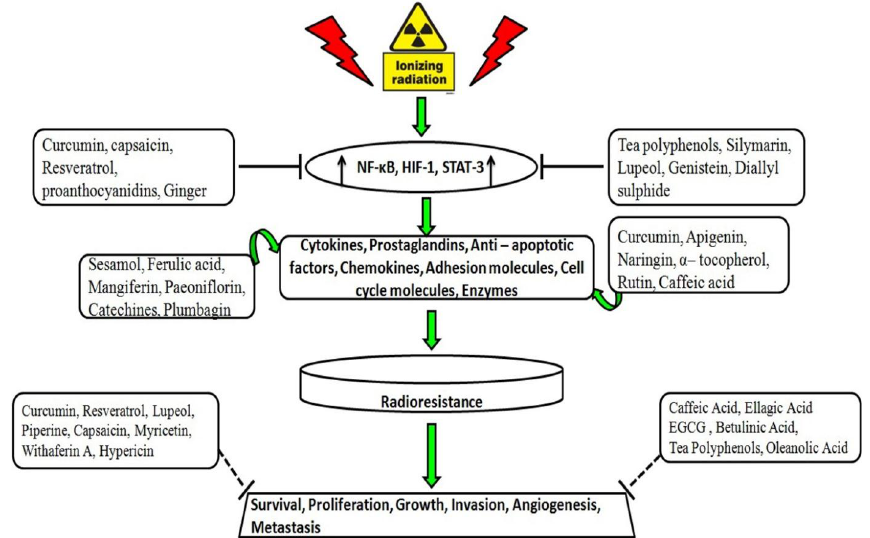
Figure 3. Selected targets of South Asian phytochemicals linked to radiosensitization. Exposure to ionizing radiation leads to activation of several transcription factors, expression of numerous cytokines, adhesion molecules, prostaglandins and enzymes that promote radioresistance. The upward black arrows depict up-regulation of indicated transcription factors. Solid lines indicate South Asian medicinal compounds inhibiting transcription potential of pro-inflammatory transcription factors. The curved green arrows indicate downregulation of expression of proinflammatory cytokines and enzymes involved in radioresistance by South Asian medicinal compounds. Dotted lines indicate South Asian medicinal compounds involved in the inhibition of prosurvival, cell proliferation, growth, invasion, angiogenesis and metastasis through various mechanisms.